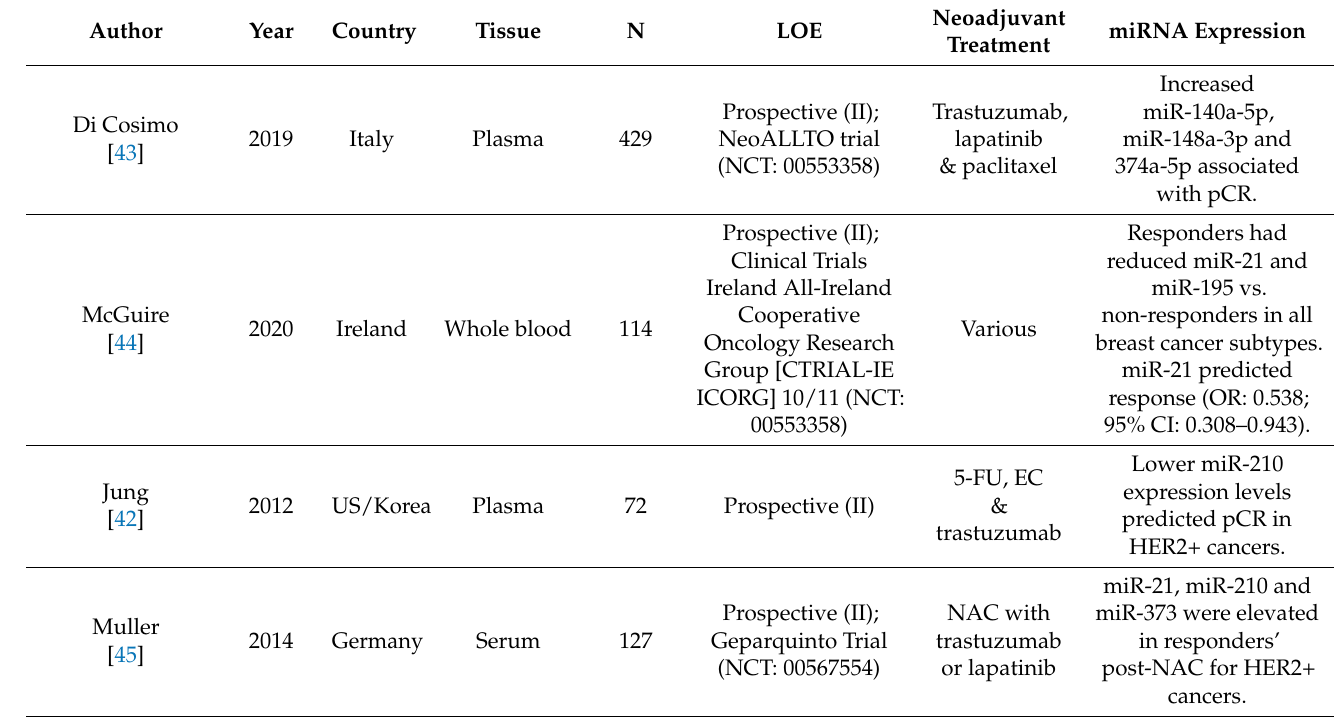
Table 2. Prospective clinical studies correlating miRNA expression profiles to response to neoadjuvant